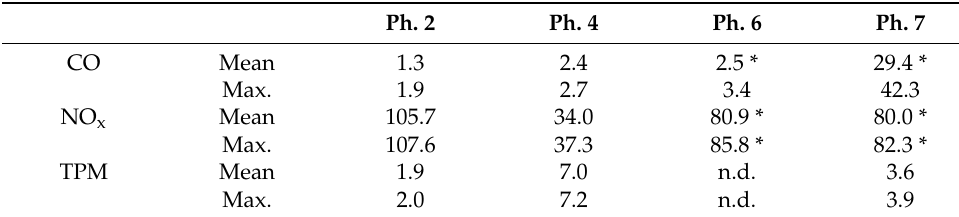
Table 4. Mean emission values (mg/m 3 ) for different process phases and all experiments for